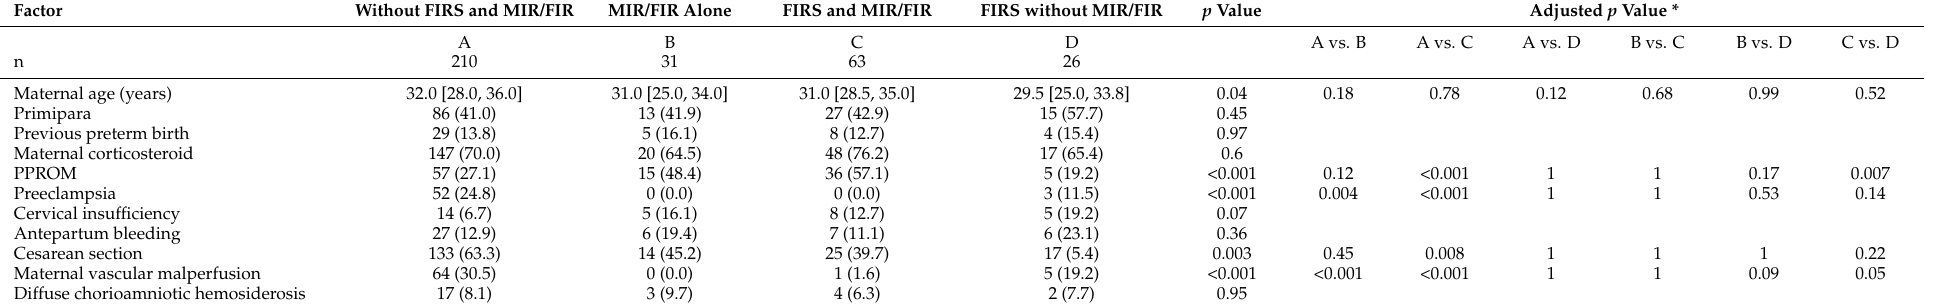
Table 1. Maternal demographic and clinical characteristics according to the presence or absence of FIRS and MIR/FIR.